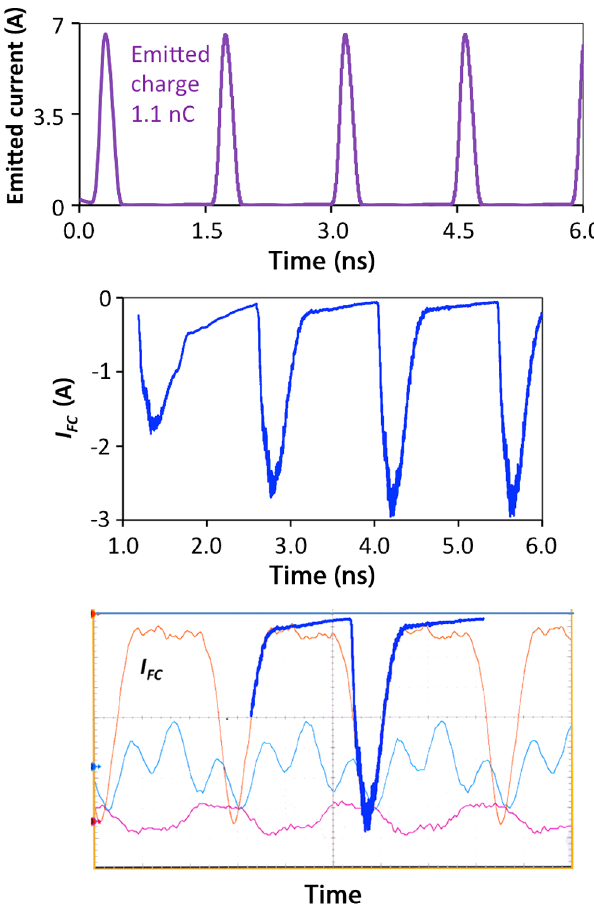
FIG. 6. MICHELLE simulation of the bunched beam for opera- tion corresponding to Fig. 5. (top) Emitted current from the cathode; (center) current reaching the Faraday cup; (bottom) comparison of simulation and experimental data from Fig.